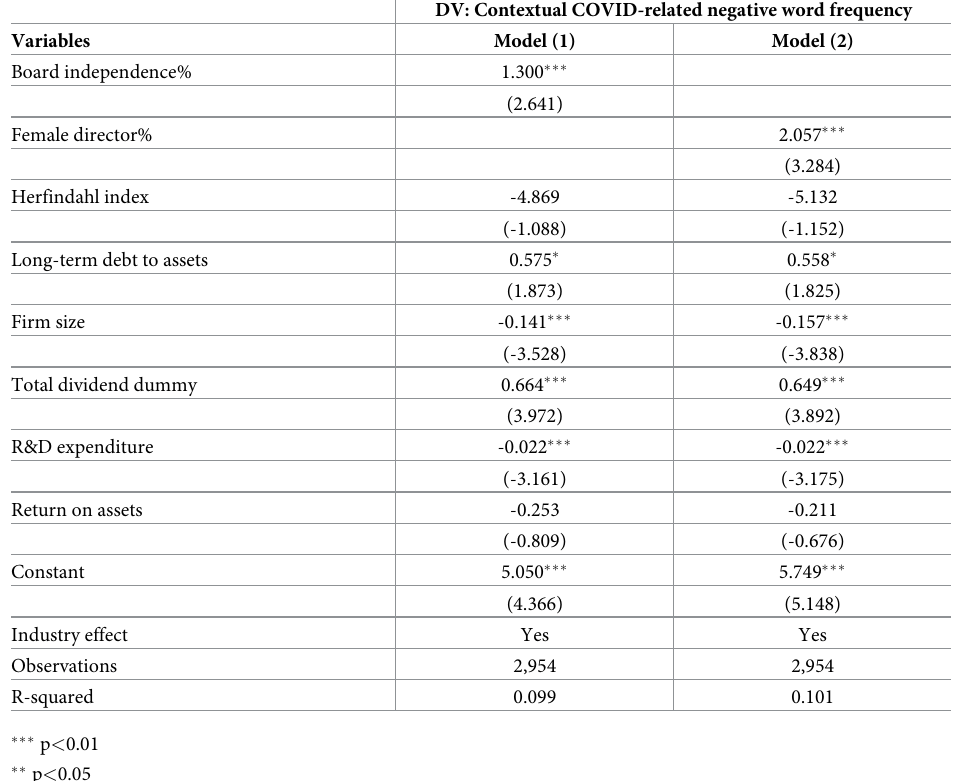
Table 9. Relationship between board-level characteristics and contextual COVID-related negative